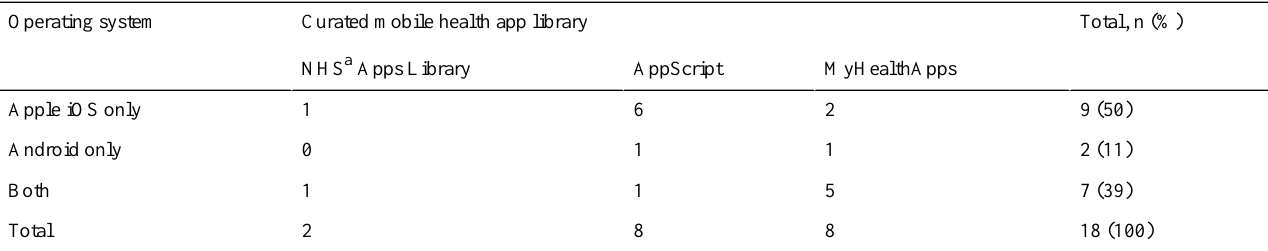
Table 2. Operating systems for apps using built-in mobile phone sensors.